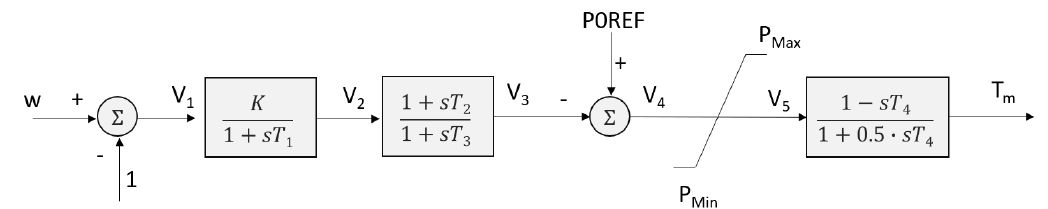
Figure A5. Steam turbine governor (adopted by [58]).